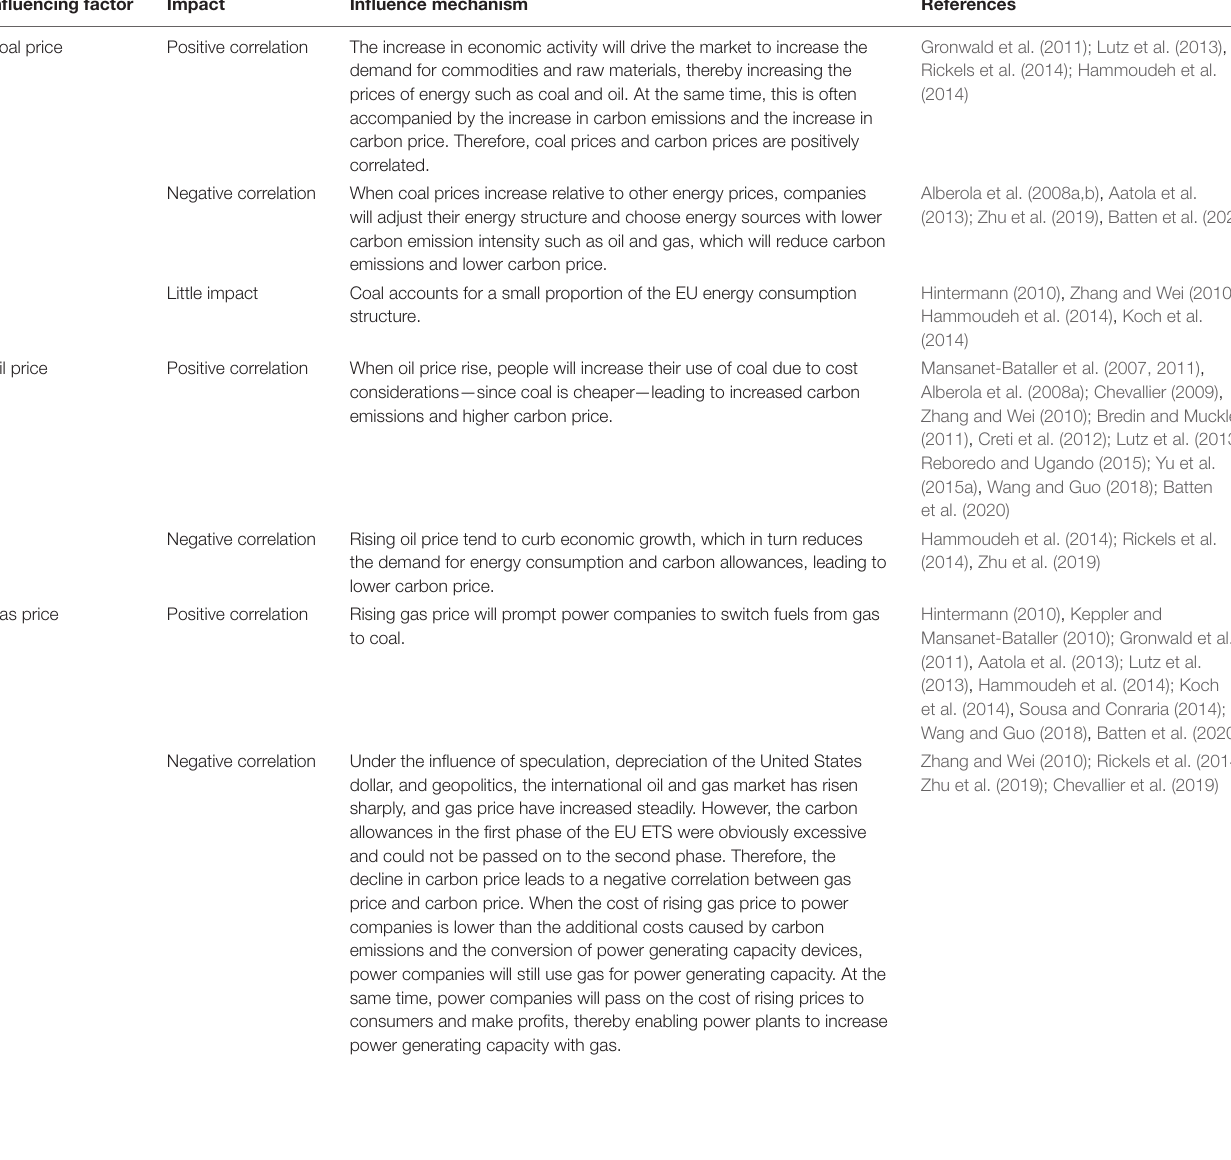
TABLE A1 | Research on the relationship between the fossil energy market and carbon